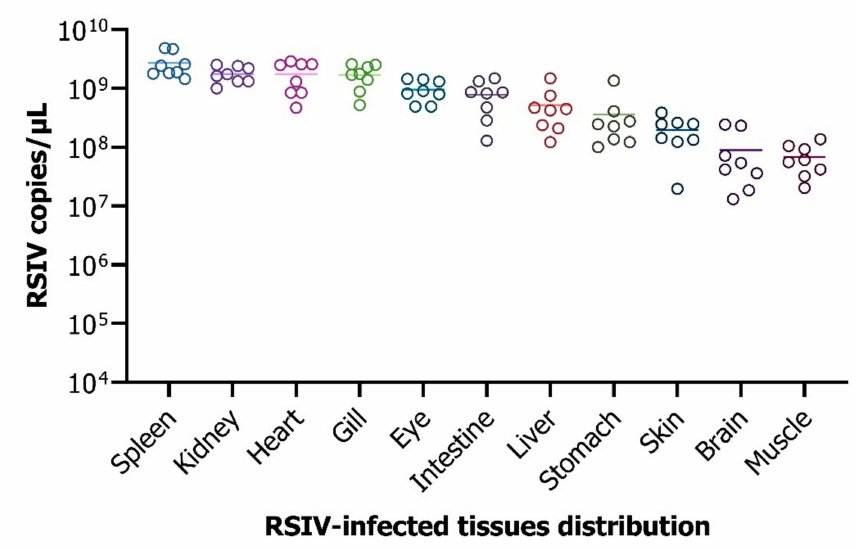
Figure 5. Tissue distribution of the red sea bream iridovirus (RSIV) in RSIV-infected rock bream fish ( Oplegnathus fasciatus ). The bars represent the mean viral copy numbers ( n = 8).